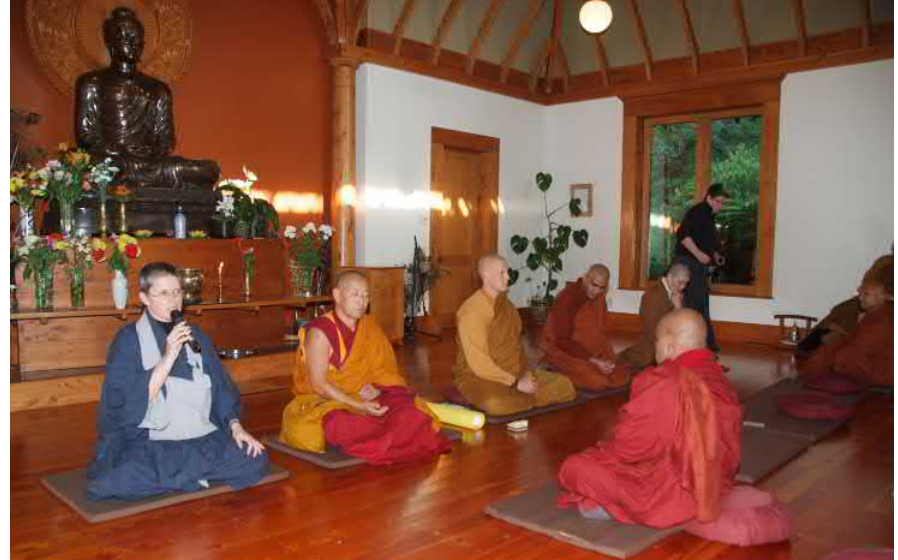
Figure 6: Invited speakers from several traditions at a seminar called “Buddhist Perspectives on Caring for the Dying and Deceased,” held at Bodhinyanarama Monastery near Wellington in 2010. (Photo by Euan Krogh)